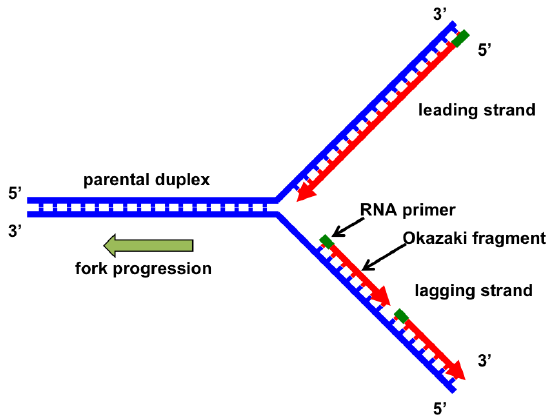
Figure 1. The replication fork. Leading-strand synthesis proceeds continuously in the 5' to 3' direction. Lagging-strand synthesis also occurs in the 5' to 3' direction, but in a discontinuous manner. An RNA/DNA primer (labeled in green) initiates leading-strand synthesis and every Okazaki fragment on the lagging